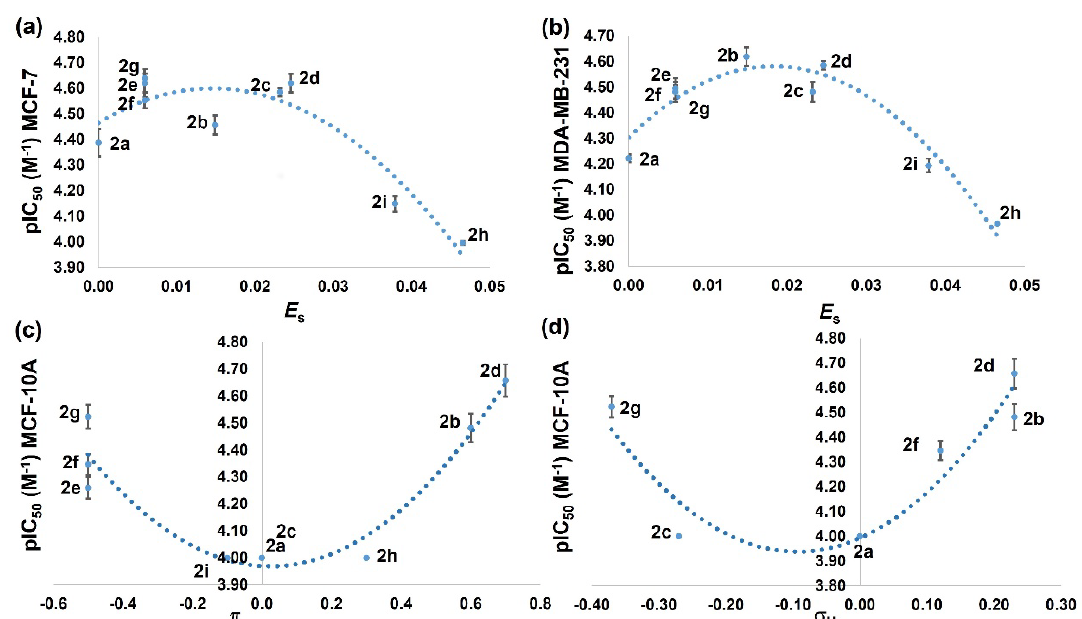
Figure 6. Quantitative structure–activity relationship (QSAR) between the pIC 50 (M − 1 ) and Es values of DPCH derivatives on BC cellular lines ( a ) MCF-7 and ( b ) MDA-MB-231. QSAR between the pIC 50 (M − 1 ), ( c ) π , and ( d ) σ H values of DPCH derivatives on healthy cellular line MCF-10A. Polynomial regression of second order through one-way ANOVA test and constant values were analyzed by Student’s t -test: ( a ) pIC 50 = -638.5 ± 1.6 E S 2 + 18.6 ± 0.7 E S + 4.46 ± 0.04 ( n = 9, p < 0.05, r = 0.9266); ( b ) pIC 50 = -831 ± 36 E S 2 + 30.4 ± 1.3 E S + 4.30 ± 0.02 ( n = 9, p < 0.001, r = 0.9634); ( c ) pIC 50 = 1.50 ± 0.15 π 2 –0.076 ± 0.011 + 3.969 ± 0.002 ( n = 9, p < 0.01, r = 0.9584); ( d ) 6.4 ± 0.6 σ H2 + 1.20 ± 0.12 σ H + 3.993 ± 0.002 ( n = 6, p < 0.05, r = 0.9186). The p < 0.05 and p < 0.01 values represent statistically significant differences